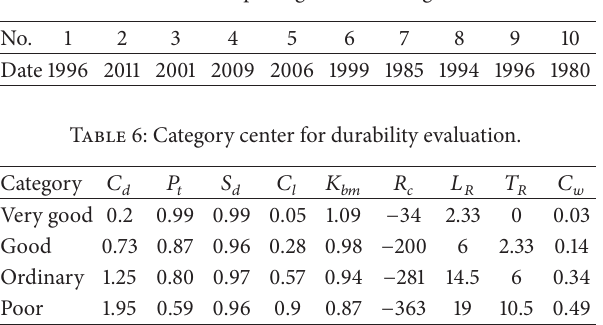
Table 5: Opening data for bridge.